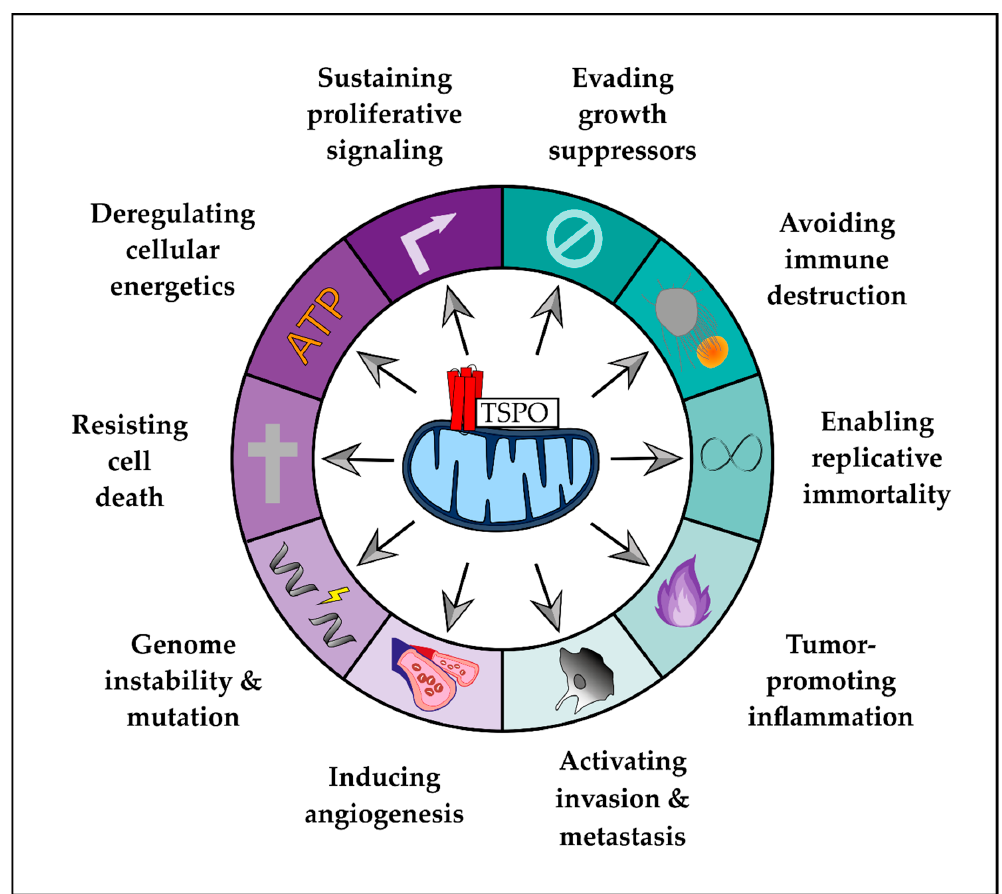
Figure 1. Translocator protein (TSPO) and the hallmarks of cancer. This illustration summarizes the ten hallmarks of cancer as proposed by Hanahan and Weinberg [31], which might be modulated by the translocator protein TSPO (adapted from [31]).